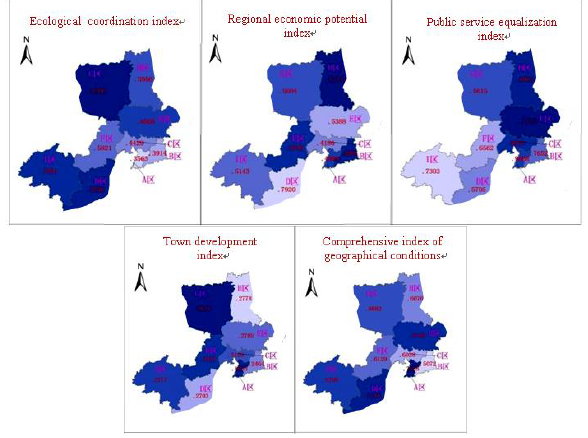
Figure 3. Index and object layer